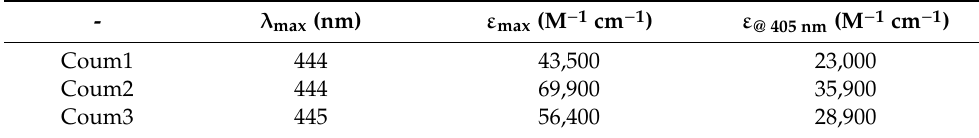
Figure 4. UV-visible absorption spectra in chloroform: (1) Coum1, (2) Coum2 and (3) Coum3. Table 2. Light absorption properties of coumarin compounds at 405 nm and λ µαζ